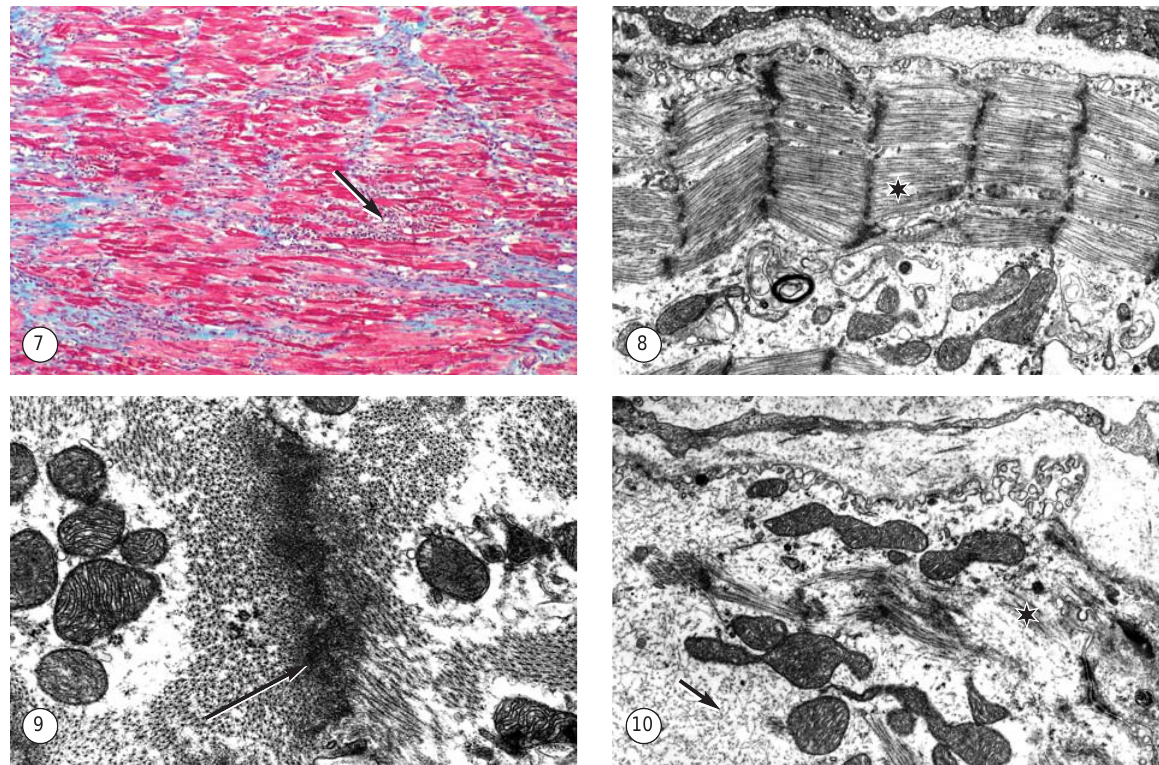
FIG. 7 Multifocal small foci of predominantly lymphocytic infiltration (arrow) were present in all the sheep. Masson’s trichrome X100 FIG. 8 Degenerative fibrils had a frayed appearance (star) FIG. 9 Note disintegrated myofilaments in cross section (arrow) FIG. 10 Disintegrated myofilaments (arrow) were often intermingled with cellular organelles, e.g. mitochondria. Intercalated disc (star)